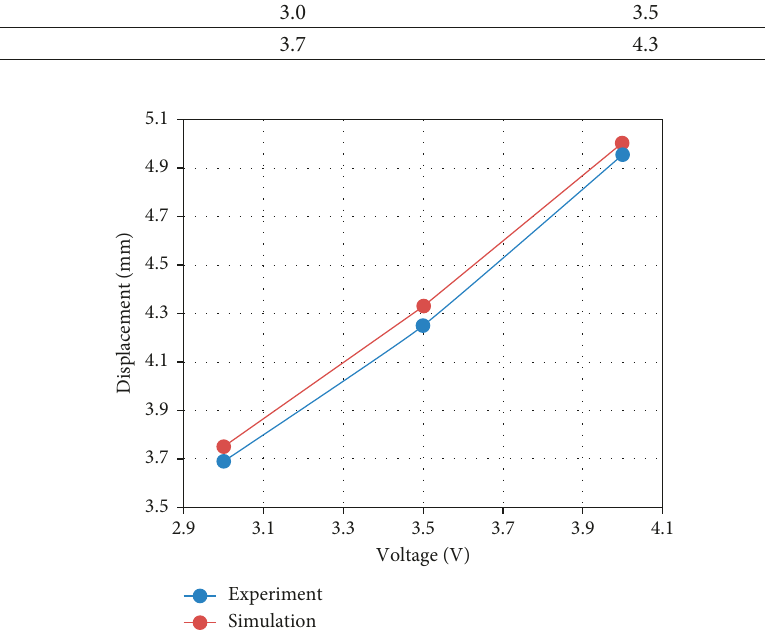
Figure 15: Comparison of the displacement calculation data with experimental data.